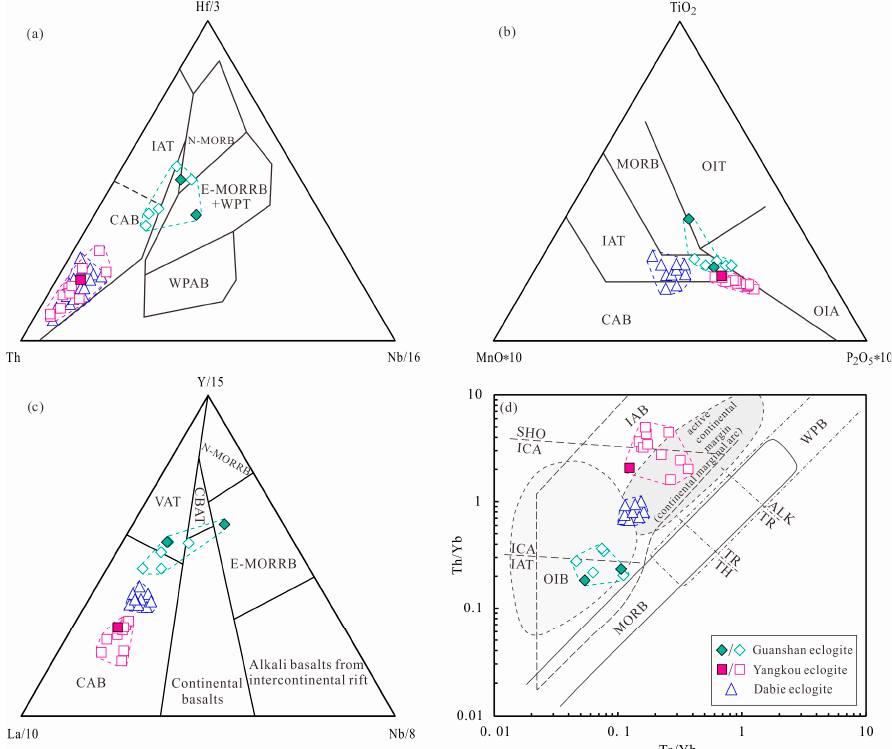
Figure 10. ( a ) Hf/3-Th-Nb/16 diagram [59]. ( b ) TiO 2 -MnO ×10-P 2 O 5 ×10 diagram [60]. ( c ) Y/15-La/10-Nb/8 diagram [61]. ( d ) Th/Yb-Ta/Yb diagram [62]. Note: WPT: within plate tholeiites, OIA: ocean island alkalic basalts, WPAB: within plate alkaline basalts,OIT: ocean island tholeiites, VAT: Volcanic arc tholeiites, CBAT: Continental back-arc tholeiites, E-MORB: enriched mid ocean ridge basalts, N-MORB: normal mid-ocean ridge basalts, MORB: mid ocean ridge basalts, OIB: ocean island basalts, SHO: shoshonite, WPB: within plate basalts, IAT: island arc tholeiites, ICA: island calc-alkaline basalts, CAB: calc-alkaline basalts, IAB = island arc alkalic basalts. Symbols of Guanshan and Yangkou ecolgites are the same as in Figure 3.